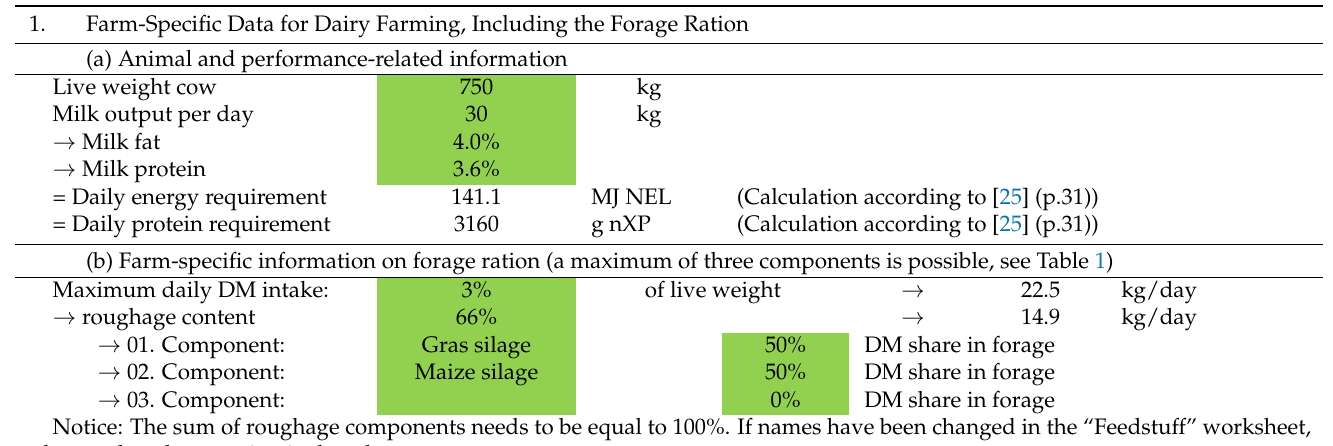
Table A1. Input interface Dairy Cow (green cells are input